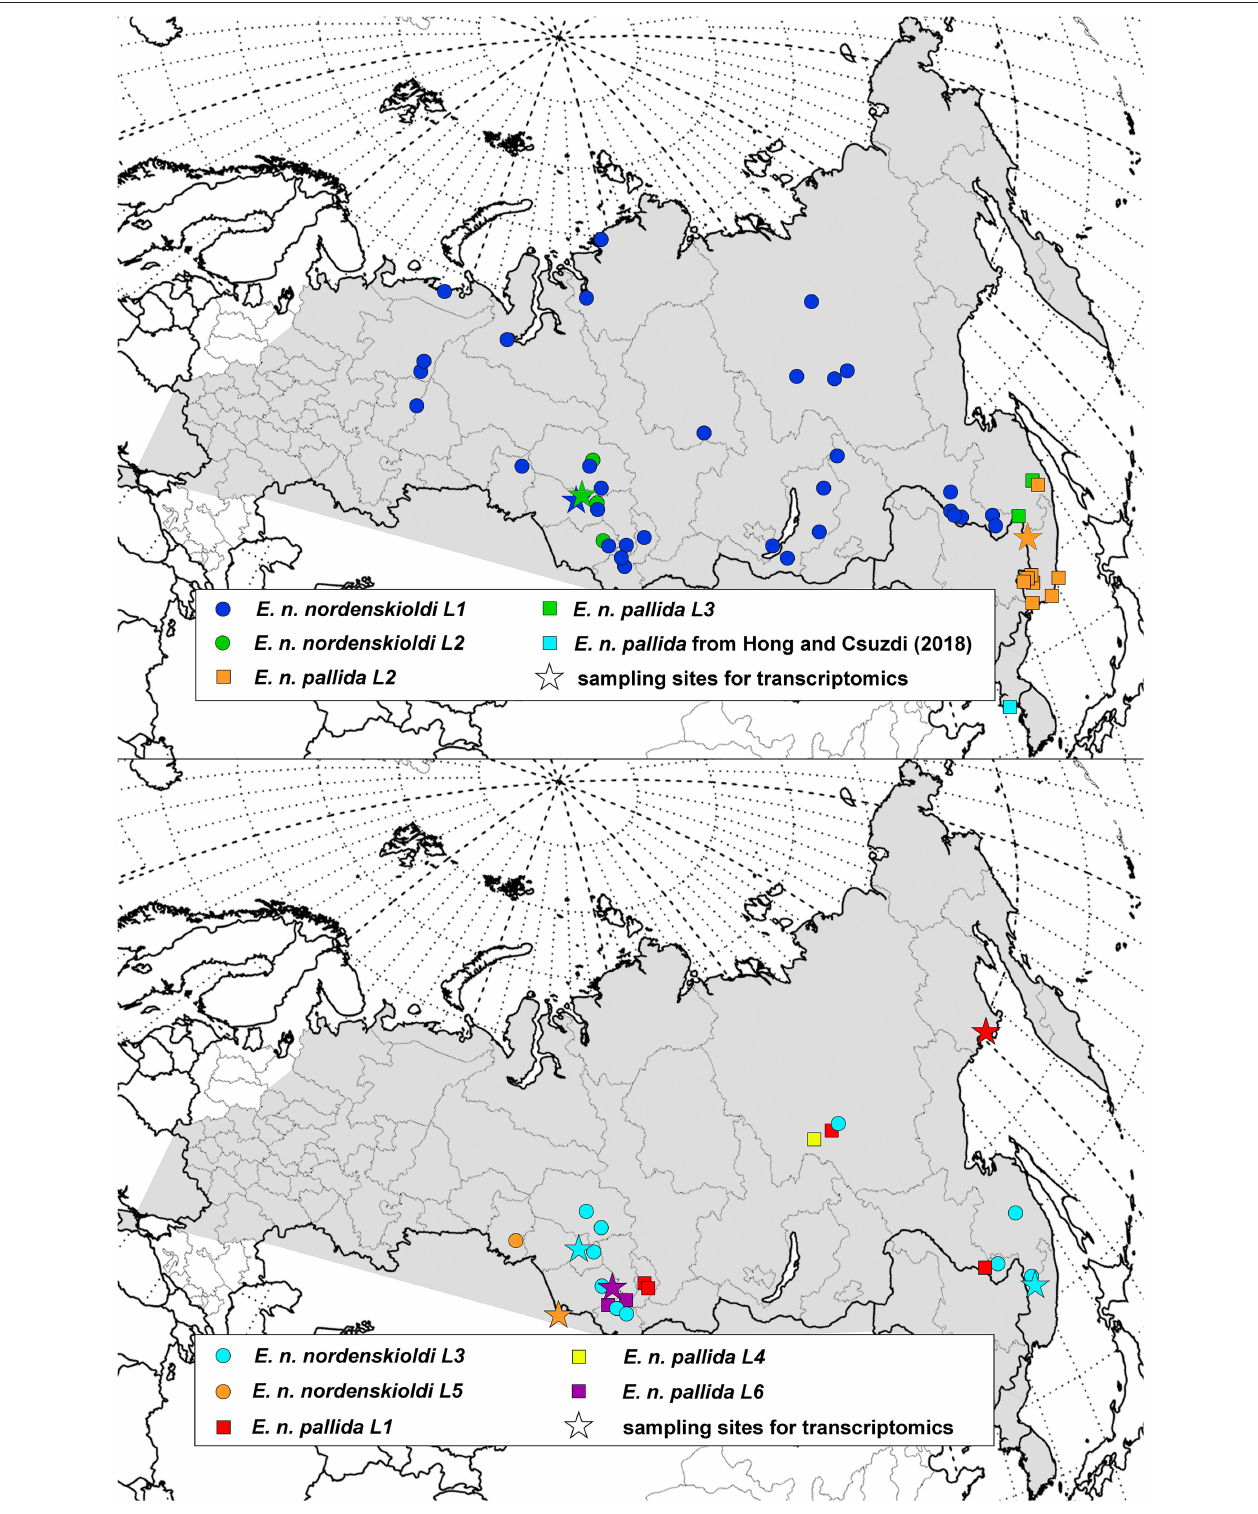
FIGURE 2 | Geographic distribution of the genetic lineages of Eisenia sp. 1. Distribution of the E. nordenskioldi complex is shown in gray. Color and symbol code refers to Figures 1 , 3 , 4 .